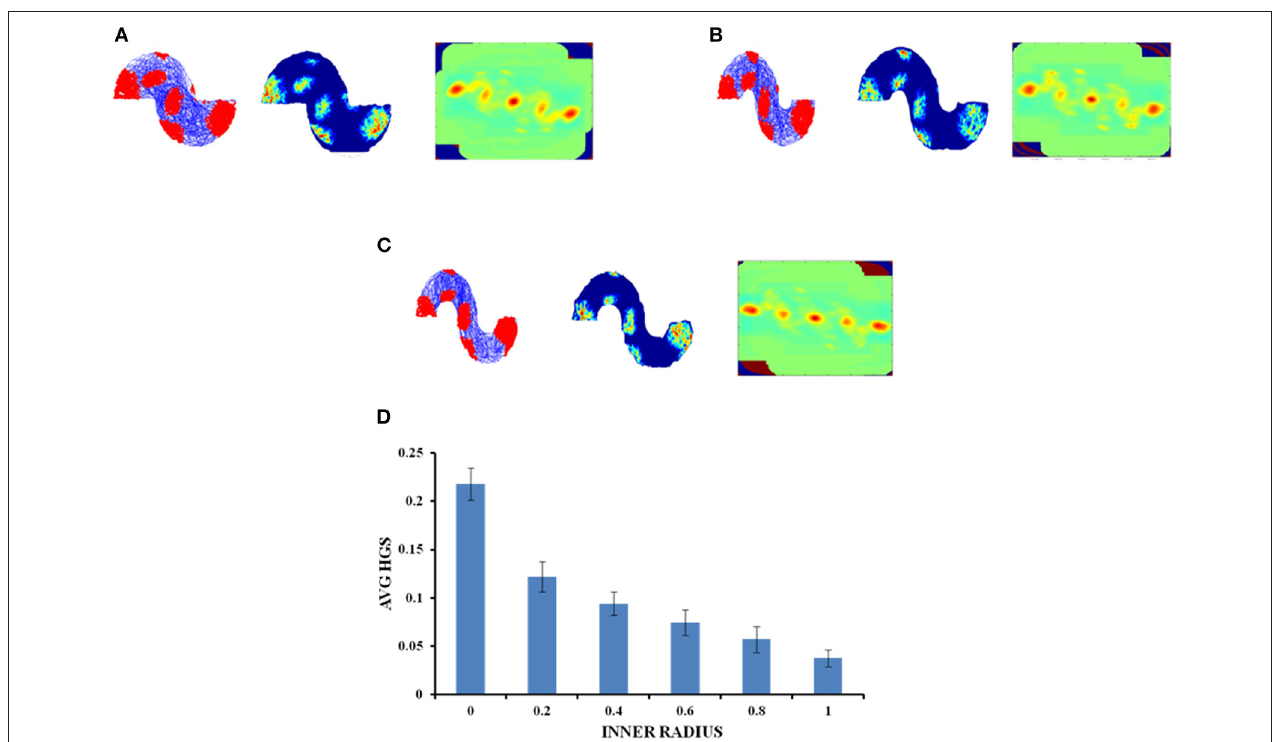
FIGURE 8 | Grid cell response in S-Shape Boundary. (A–C) Firing field, firing rate, and auto correlation maps of S shape boundary with varying inner radii of 0, 0.8, and 2, respectively. (D) Average HGS values vs. varying inner radii of S- Shape.